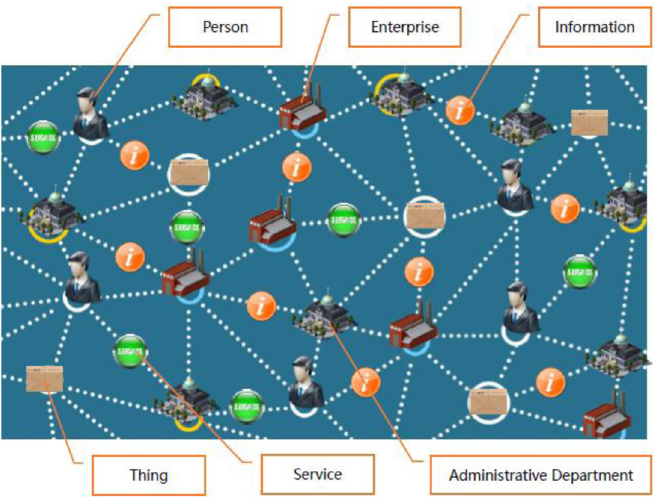
Figure 2. Interactions between the MCIN